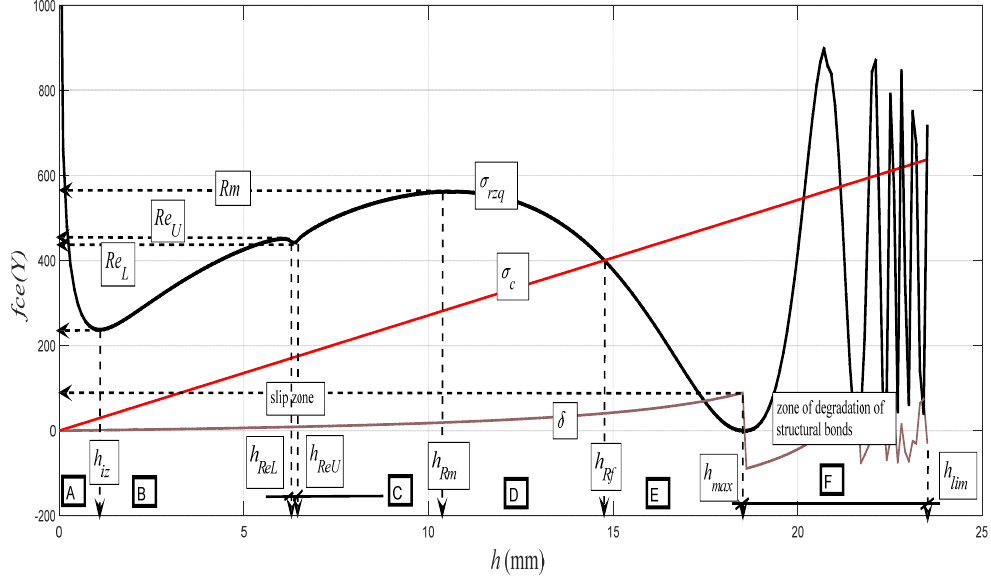
Figure 14. Entire development of the deformation stress for the steel grade AISI 309 in the case of dependence σ rzq = f ( h ). σ rzq (black color), σ c (red color), and δ (brick color).